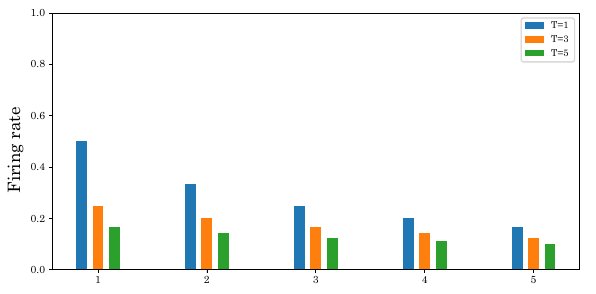
Figure 4. Relationship between refractory period r = ( ν T = 1,3,5 [ms].